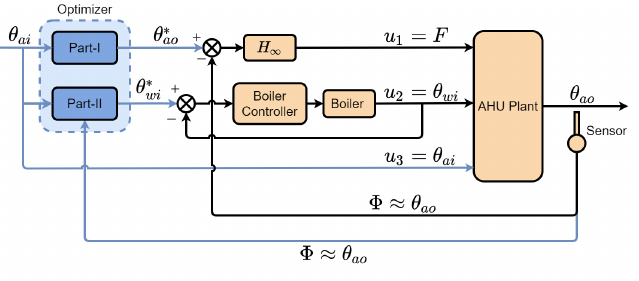
Figure 3. Structure of control